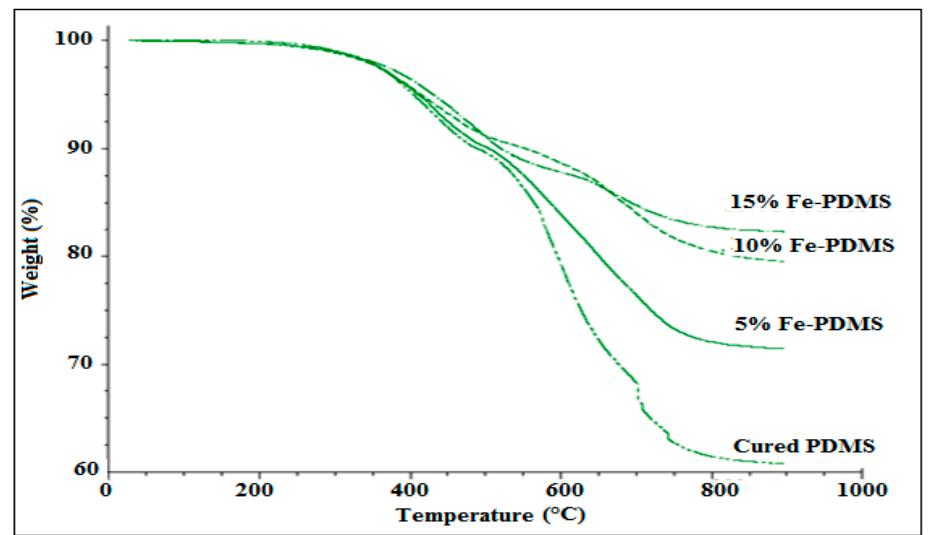
Figure 6. TGA of cured PDMS and PDMS composites as a function of iron content under nitrogen.